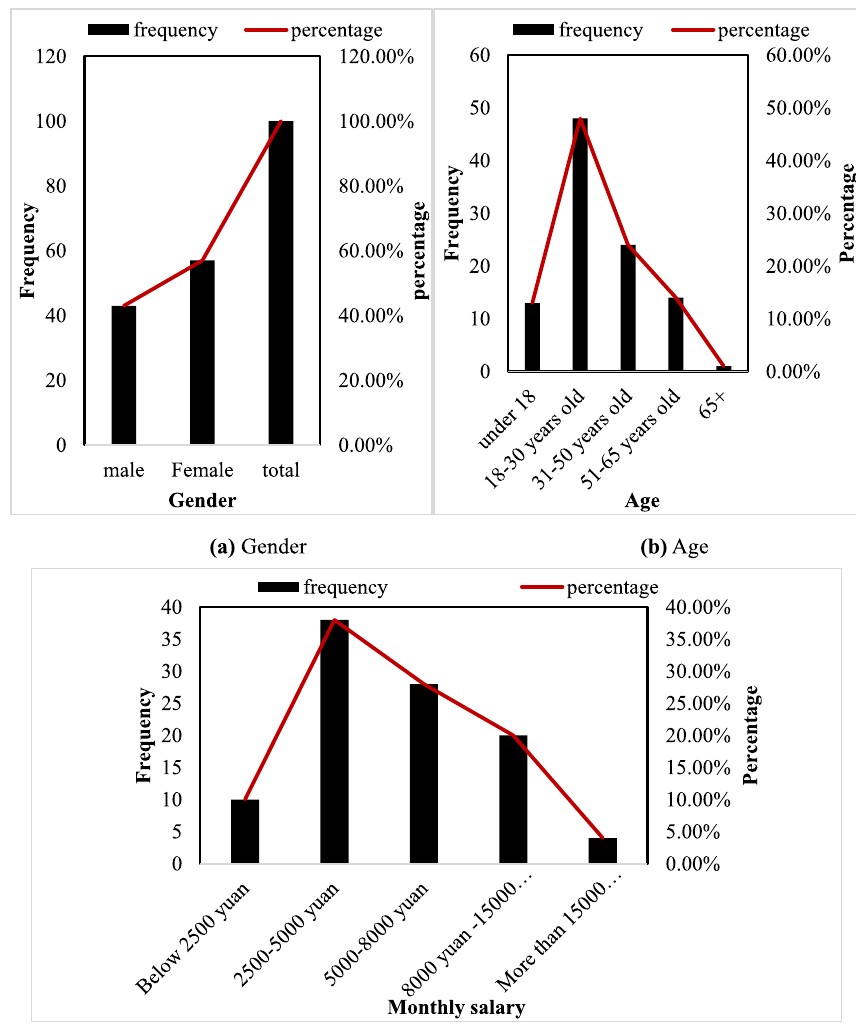
Fig. 7 Basic information of the surveyed citizens. a Gender, b Age, c Monthly income